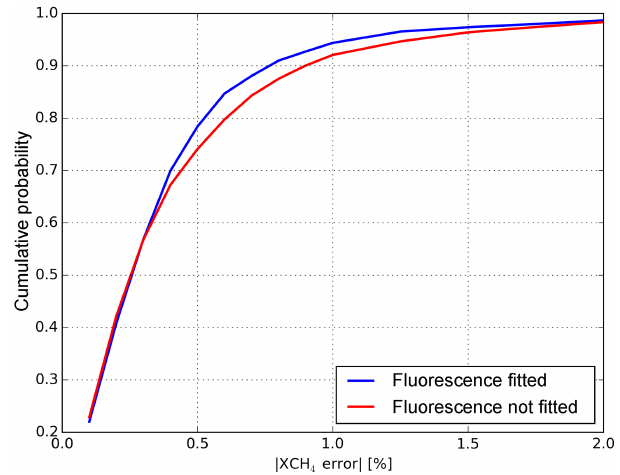
Figure 5. Cumulative probability distribution of the absolute XCH 4 forward model error for the baseline retrieval (blue line) and for the case that fluorescence emission is not fitted (red